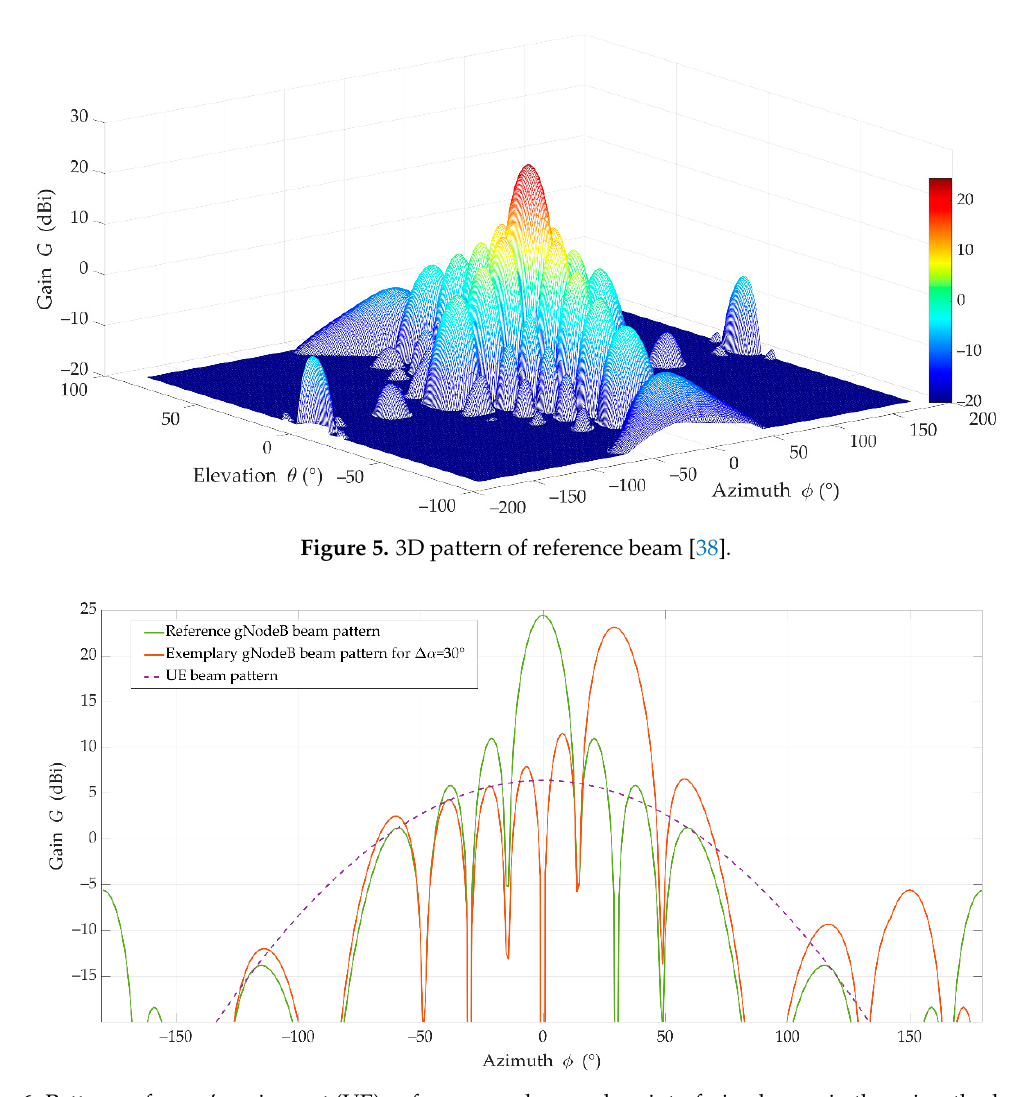
Figure 6. Patterns of users’ equipment (UE), reference, and exemplary interfering beams in the azimuth plane [38].